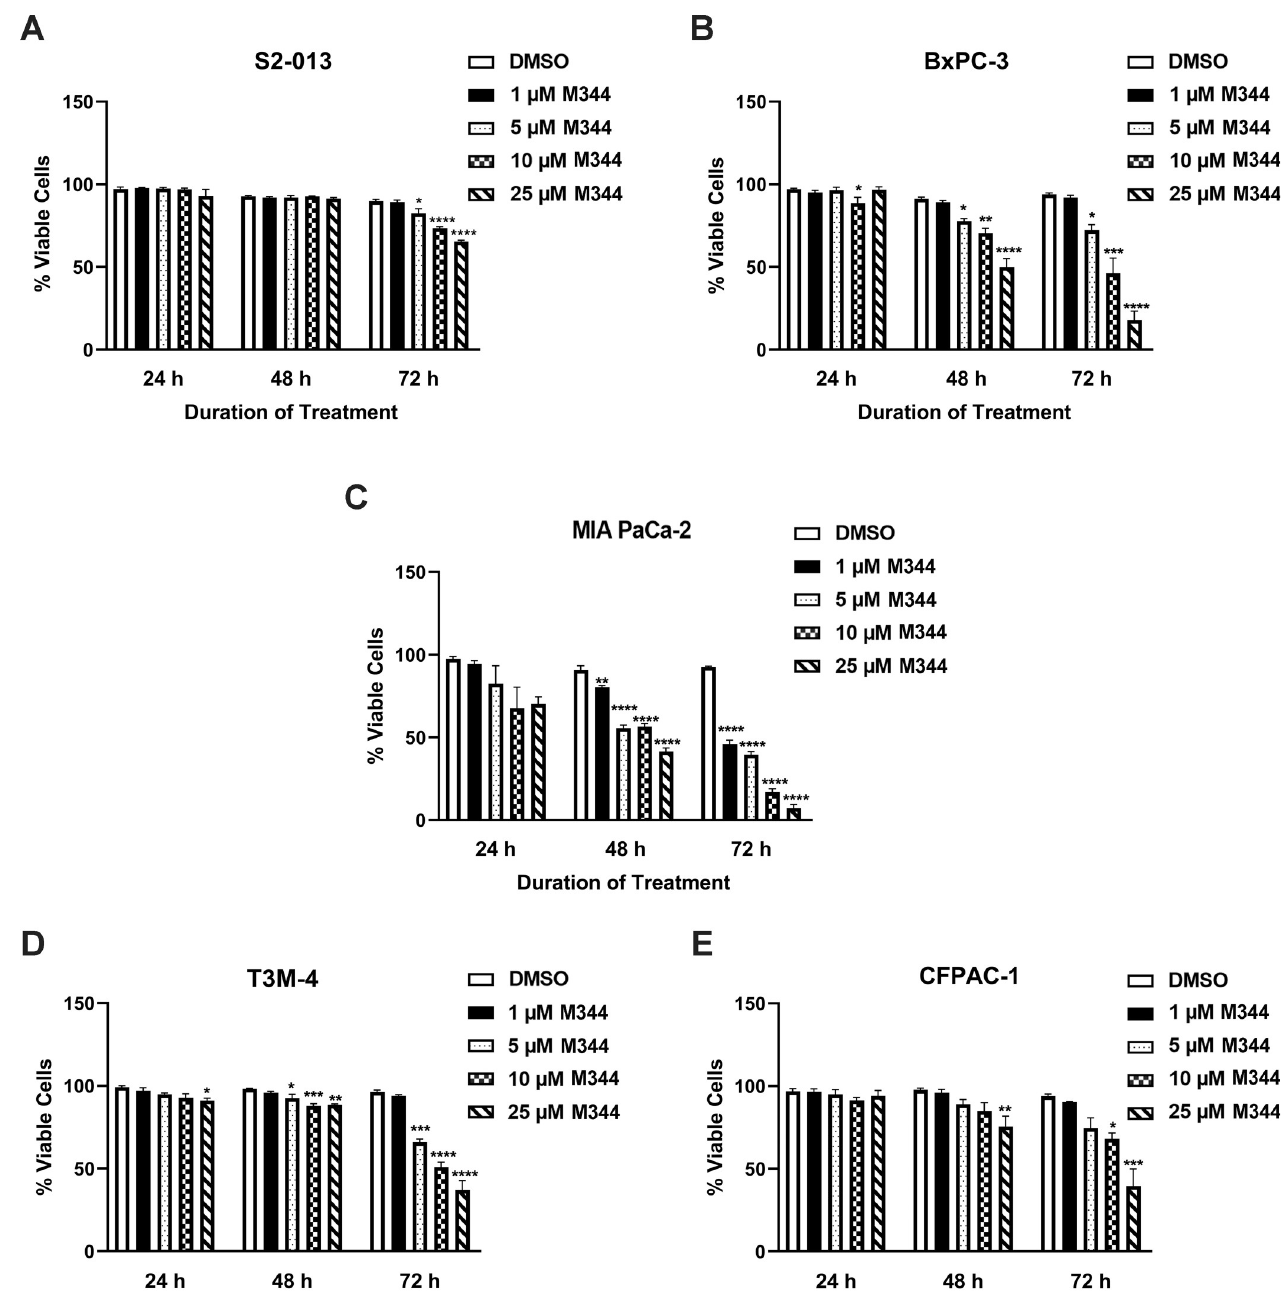
Fig 2. Pancreatic cancer cell viability is diminished by M344 treatment. After treatment with M344 at various concentrations, the viability of ( A ) S2-013, ( B ) BxPC-3, ( C ) MIA PaCa-2, ( D ) T3M-4, and ( E ) CFPAC-1 cells was assessed by the trypan blue exclusion assay at 24, 48, and 72 h. Viability was graphed as the number of live cells/total cells x 100. Each error bar represents the standard error of the mean. These results are representative of findings in 2–3 separate experiments for each cell line. The results from 0.1% DMSO control treatment versus treatment with each M344 concentration were compared using Ordinary One-way ANOVA with Dunnett’s Multiple Comparisons test in GraphPad Prism Version 8.4.2. The asterisks indicate the following p values: � p < 0.05, �� p < 0.01, ��� p < 0.001, ���� p < 0.0001.